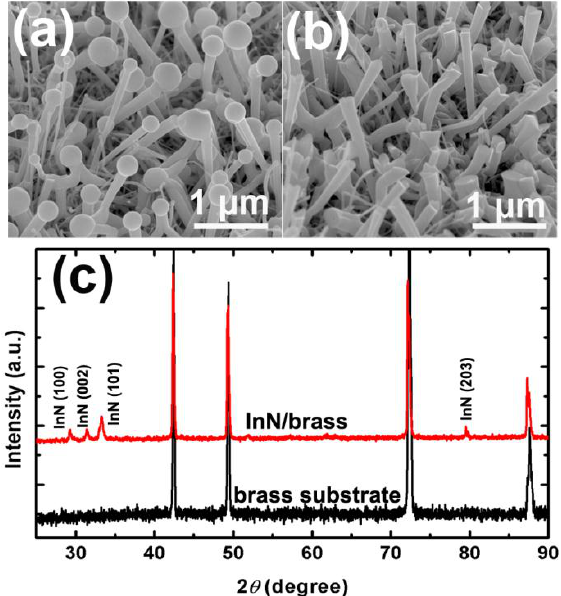
Figure 2. SEM and X-ray diffraction (XRD) characterization of the InN nanowires. Tilted view SEM images of ( a ) the as-grown nanowires and ( b ) the nanowires etched in diluted HCl solution. ( c ) XRD pattern of the nanowires (upper line) and the original brass substrate (bottom line).